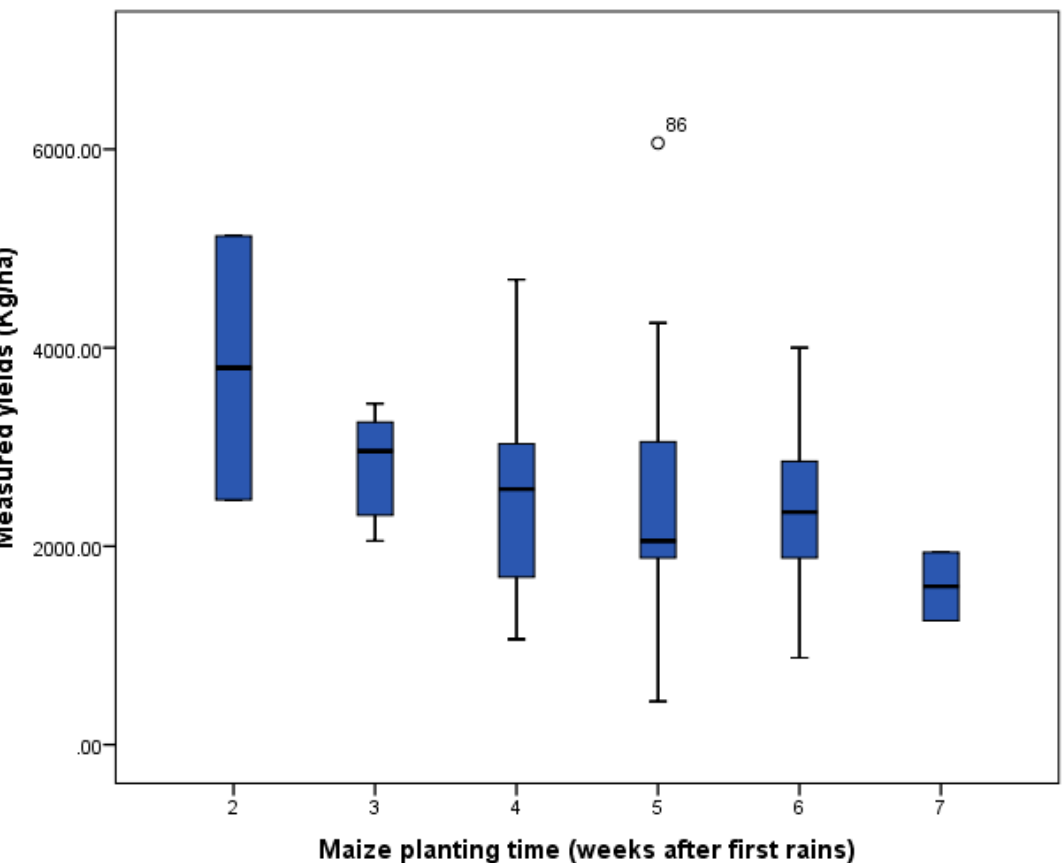
Figure 4. Boxplot showing the relationship between timing of maize planting in weeks after the first rains and CC rains and CC yields.